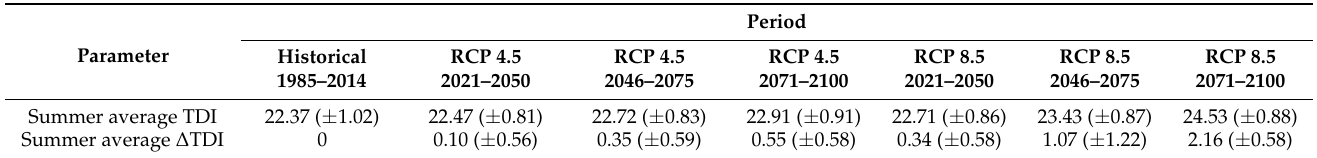
Table 5. Average summer TDI (in ◦ C) and average summer ∆ TDI (in ◦ C) values for all sites and periods considered; the standard deviation from the mean is shown in parenthesis. The definition of ∆ TDI is given in the text.